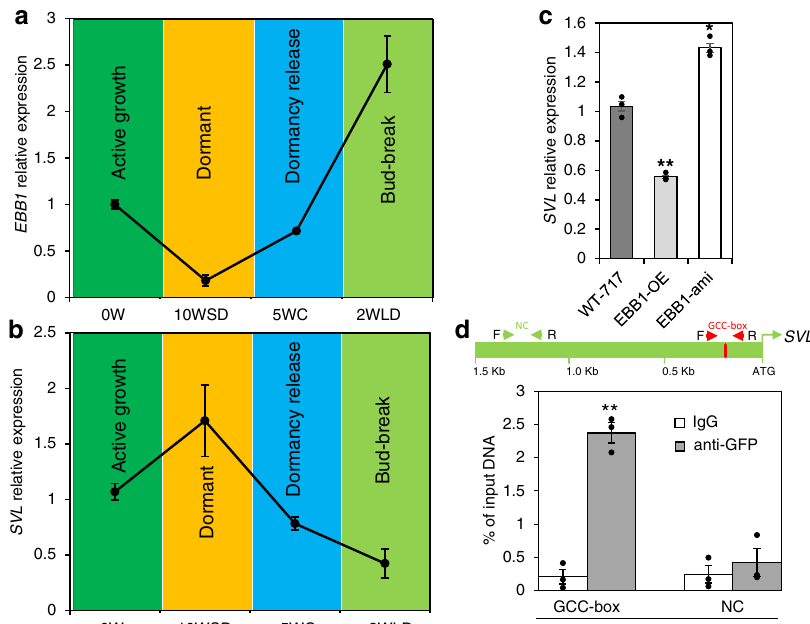
Fig. 4 EBB1 directly binds to SVL promoter in vivo in chromatin immunoprecipitation (ChIP) assays to regulate its expression. a EBB1 and b SVL relative expression during dormancy cycle and bud-break under manipulative dormancy treatments in controlled growth chamber conditions; 0 W: time point before inductive treatments, 10WSD: 10 weeks under SD photoperiod, 5WC: 5 weeks under cold, 2WLD: 2 weeks under LD photoperiod and warm temperature. c Relative expression of SVL in EBB1 over-expressing (EBB1-OE) and underexpressed (EBB1-ami) plants. Expression values are the average of three biological replicates ±SEM, the expression values normalized to the reference ACT7 gene. d Enrichment of a DNA fragment in the SVL promoter containing a GCC-box and quanti fi ed by ChIP-qPCR. The green box is a schematic representation of the SVL promoter showing the position of the GCC-box (red). Red arrows delineate the position of DNA fragments containing the GCC-box and green arrows demarcate the position of DNA fragments with no GCC-box used as a negative control (NC) in ChIP-qPCR analysis. Chromatin from EBB1-GFP DNA transfected poplar protoplasts was isolated using anti- GFP antibody and IgG used as a control antibody. ChIP-puri fi ed DNA was used to perform ChIP-qPCR, expression values are represented as the percentage of input (% of input) DNA. Values are the average of three biological replicates ±SEM. Asterisks (*) and (**) indicate extreme signi fi cant differences compared to their respective control at P < 0.003 and P < 0.0005 respectively and determined using two-tailed paired multiple t -tests. Source data underlying Fig. 4d are provided as a Source Data fi